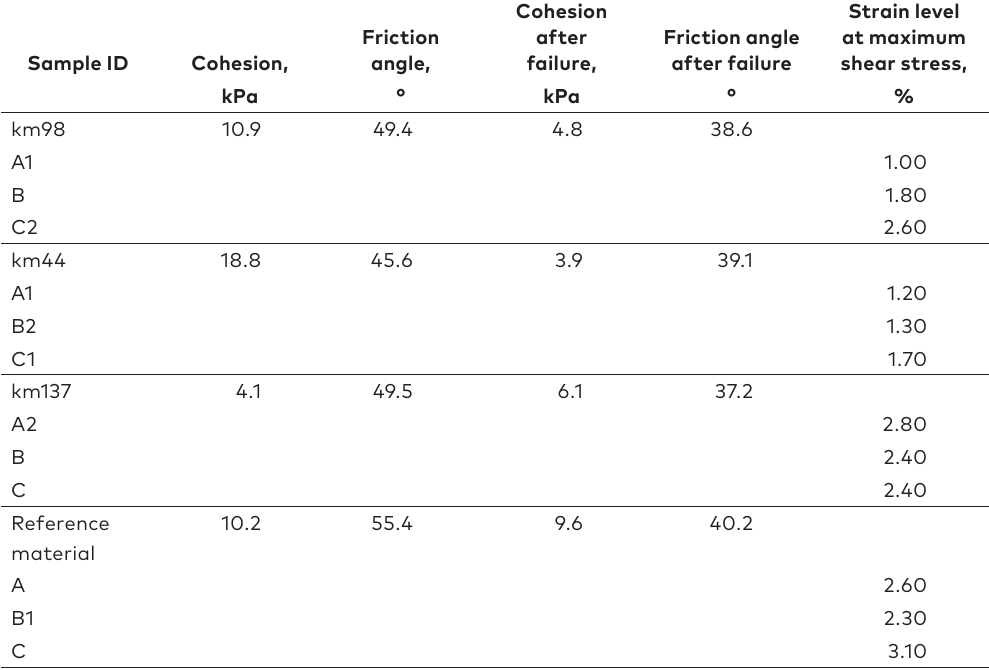
Table 3. Parameters used in the triaxial and measured material